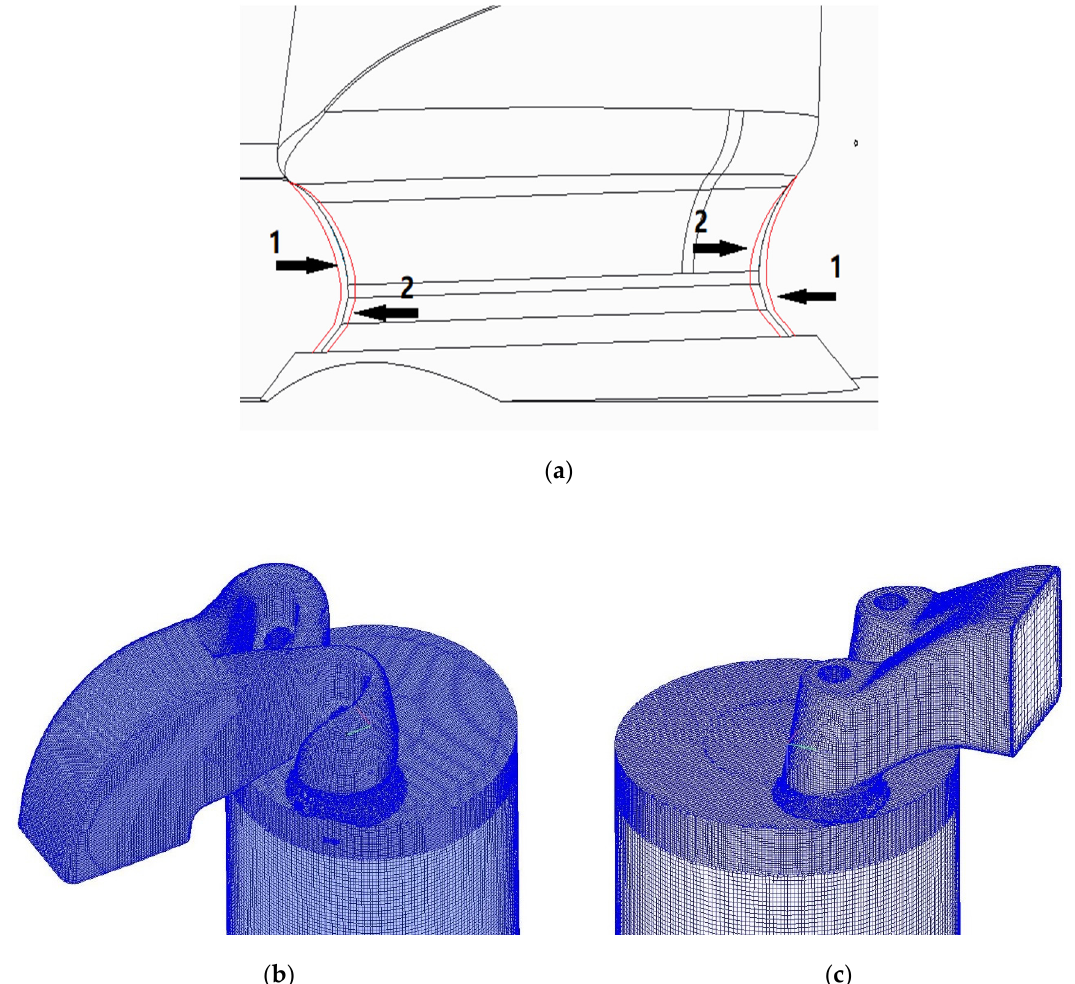
Figure 1. ( a ) Modification method of intake and exhaust throat; ( b ) intake port with a throat diameter of 43 mm; ( c ) exhaust port with a throat diameter of 49 mm. Table 2. Meshing schemes for different